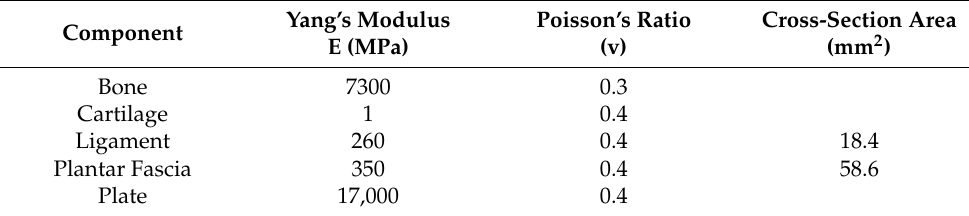
Table 1. Material parameters of foot FE model.